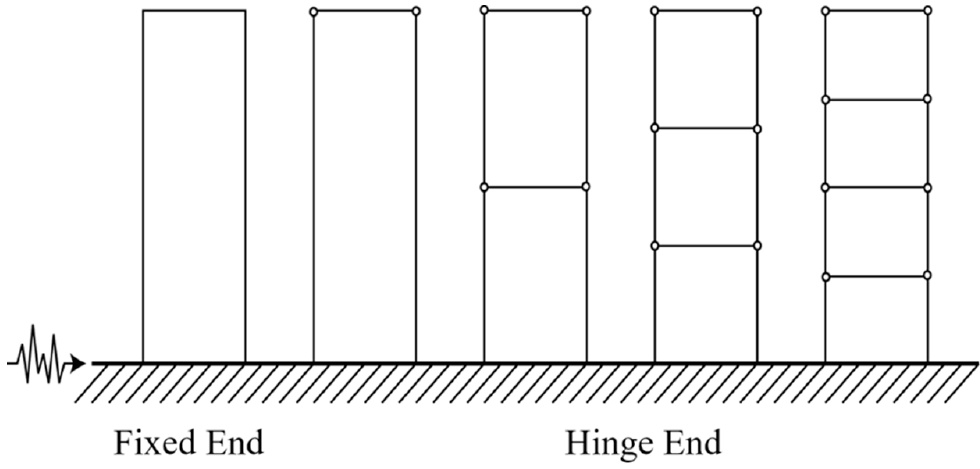
Figure 13. Analysis model of structures.